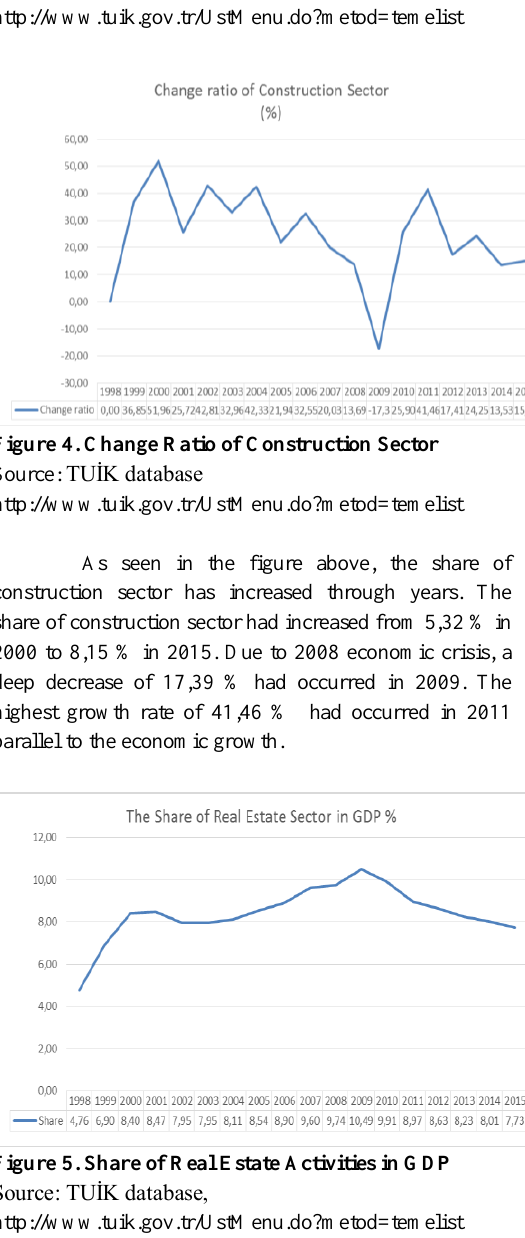
Figure 3. Share of Construction Sector in GDP Source: TUİK database,